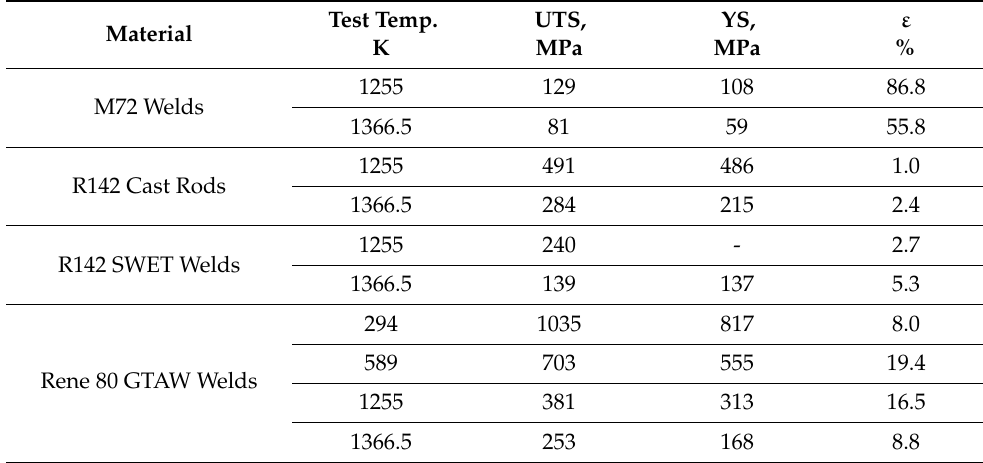
Table 1. Tensile properties of M72, R80, and R142 materials